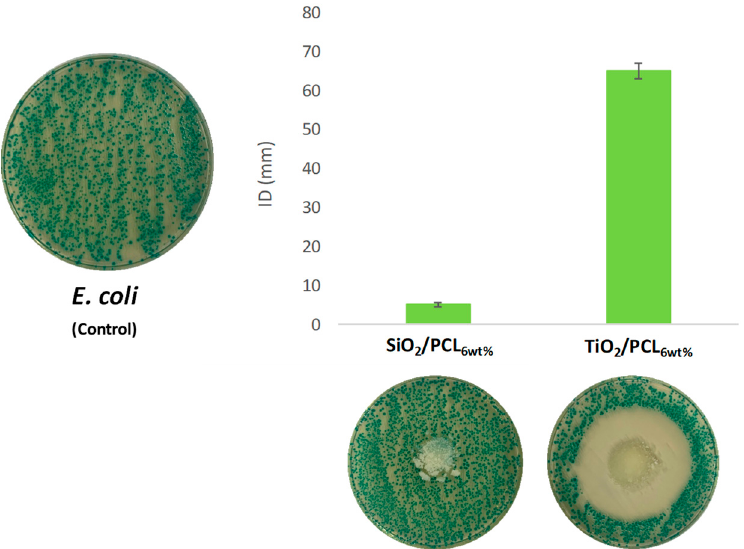
Figure 9. Representative image of Escherichia coli incubated with synthetized hybrid materials and antimicrobial activity reported as inhibitory zone diameter (mm).